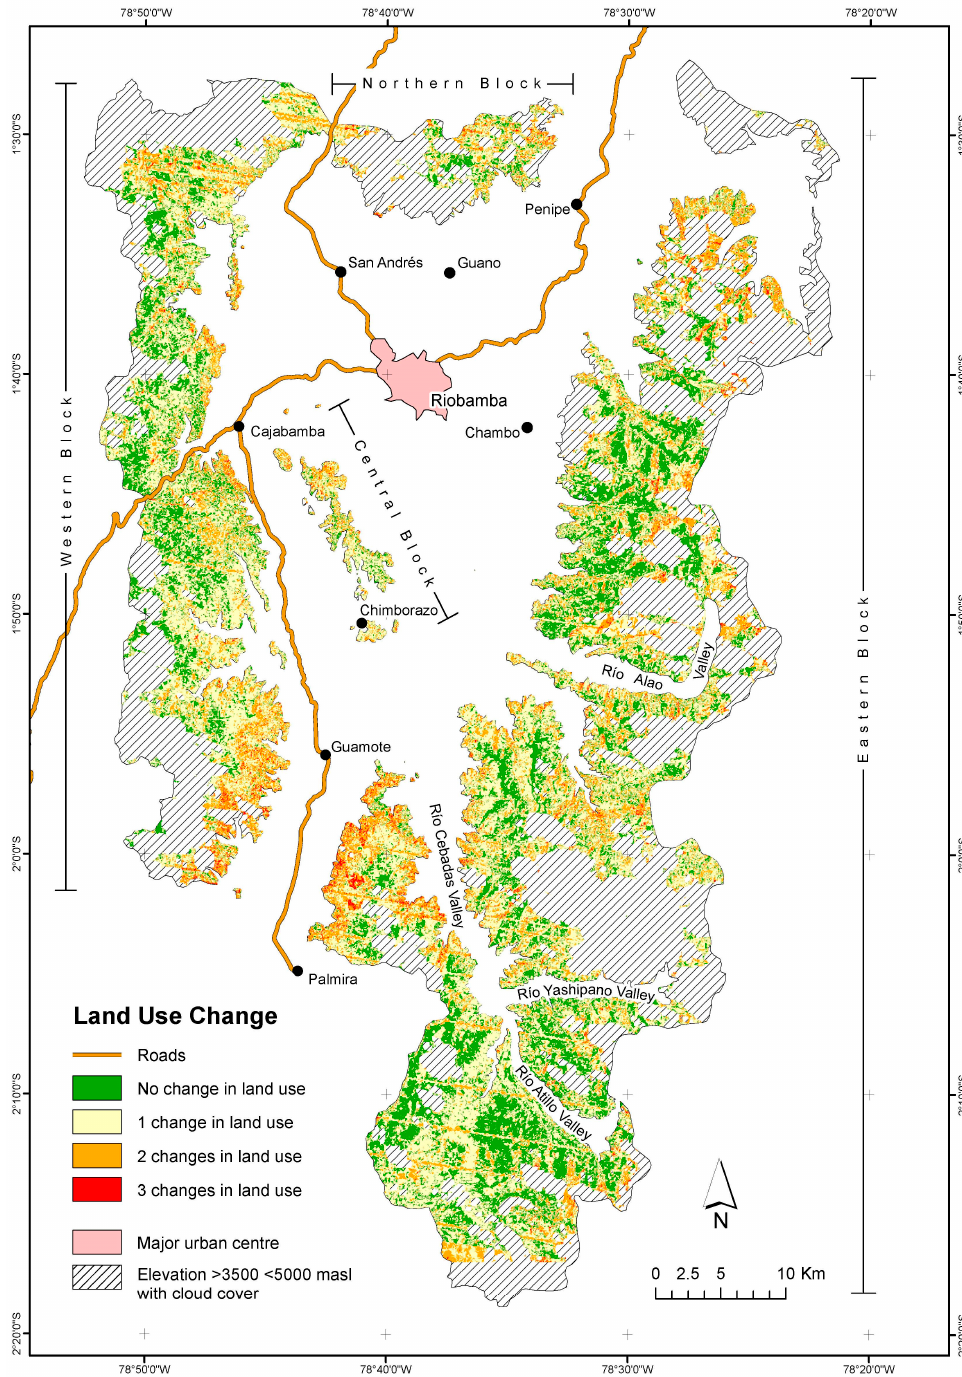
Figure 6. Chambo Basin: land-use change dynamics, 1979–2014.